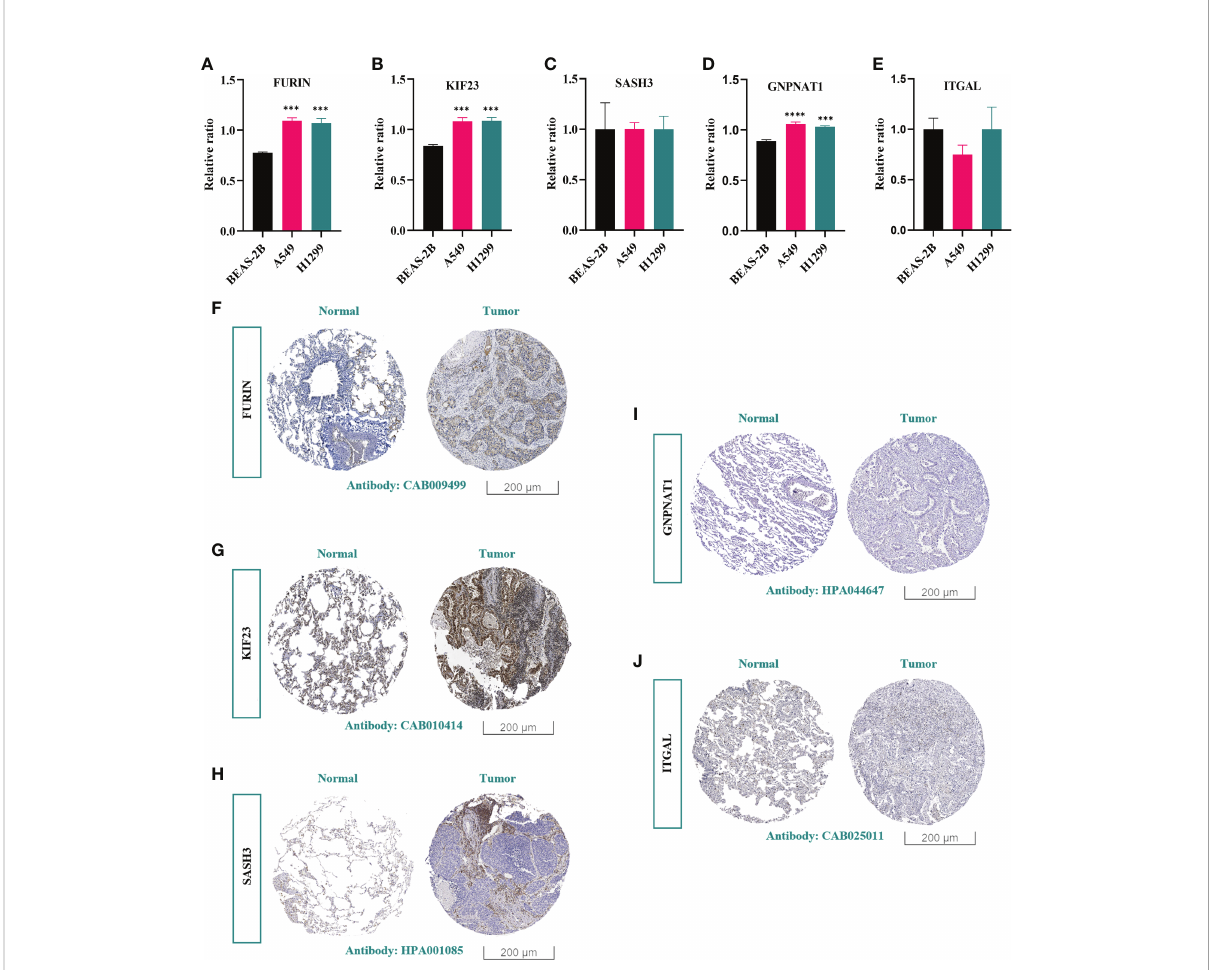
FIGURE 14 Experimental validation of key PRs. (A-E) The expression levels of 5 prognostic phagocytosis regulators in the model in BEAS-2B, A549 and H1299 cell lines were detected by RT-qPCR. ***: p < 0.001, ****: p < 0.0001. (F-J) Immunohistochemical results of FURIN, KIF23, SASH3, GNPNAT1 and